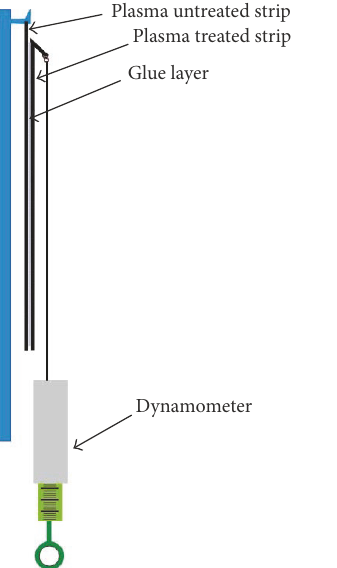
Figure 8: Method of testing the strength of the